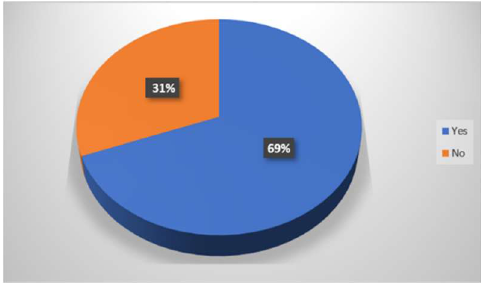
Figure 16. Answers to the second question of Unit A.